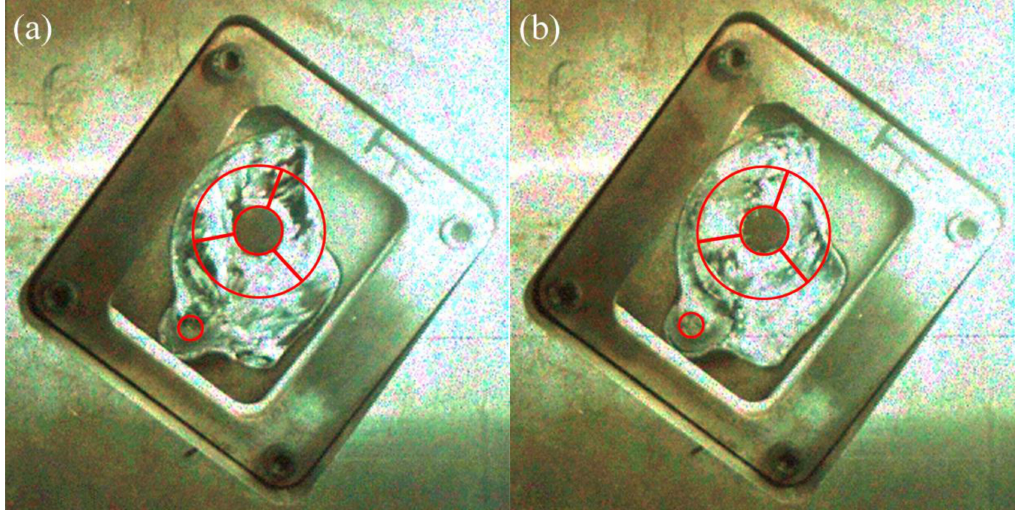
Figure 12. Flow pattern under the fast shot velocity of 0.88 m/s in the right window. ( a , b ) are arranged according to the order of